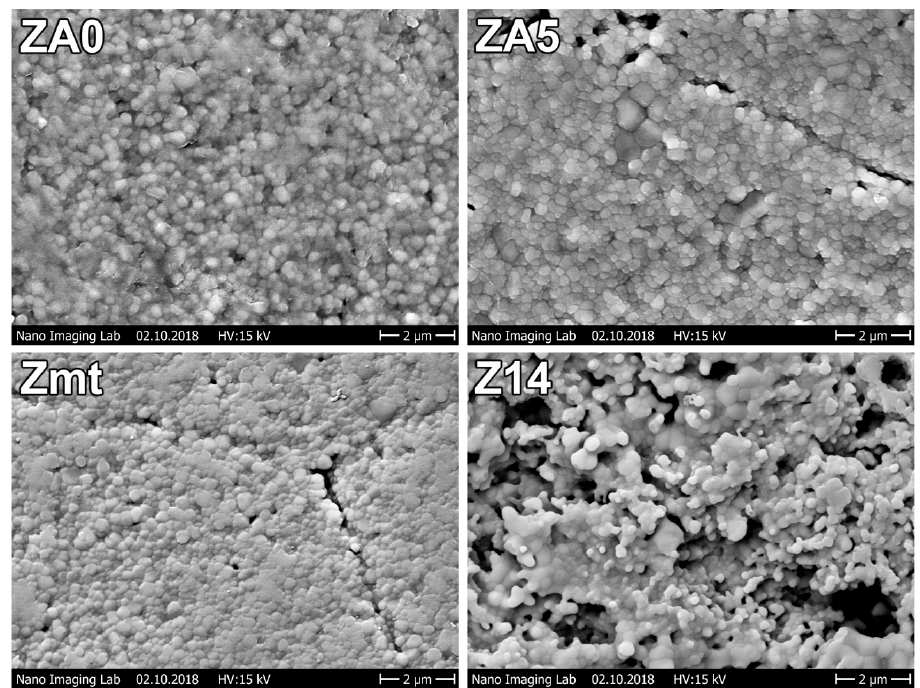
Figure 2. Specimen surface morphologies (SEM 10,000×).